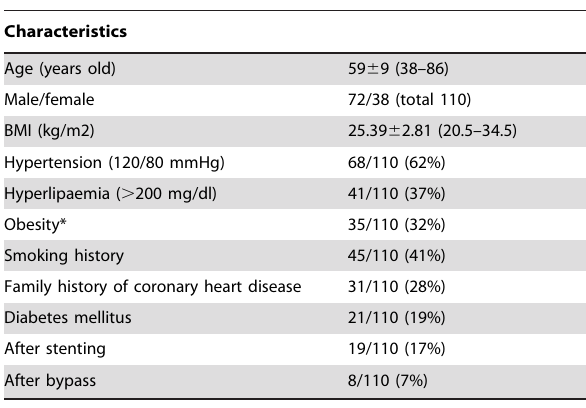
Table 1. Patient characteristics.